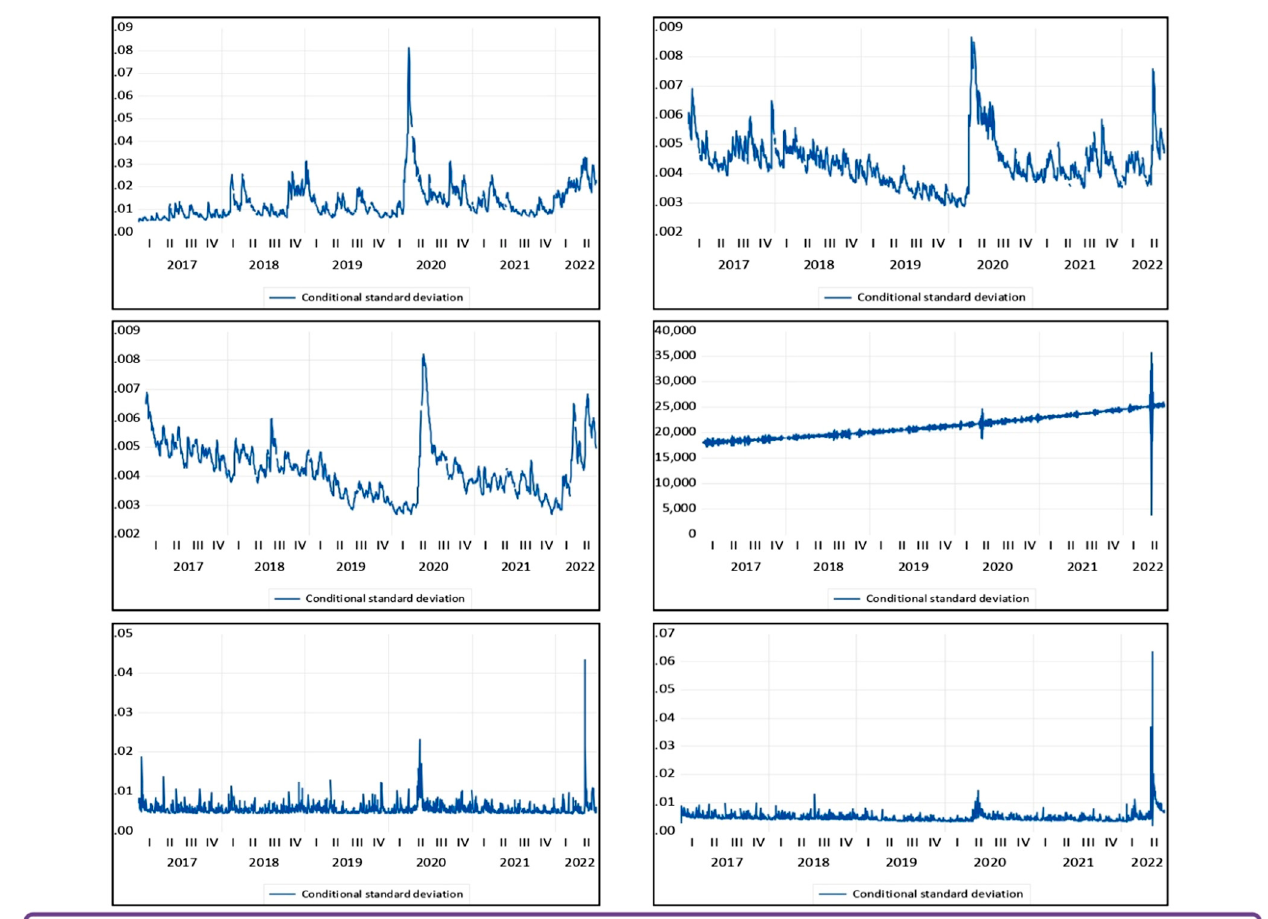
Figure 5. Graphical Representation of the variables ( a ): NASDAQ; ( b ): USD/CAD; ( c ): USD/EURO; ( d ): USD/JPY; ( e ): USD/GBP; ( f ): EURO/USD of G7 Countries under FIGARCH Estimation. Note: X axis measures time periods as represented by observations.